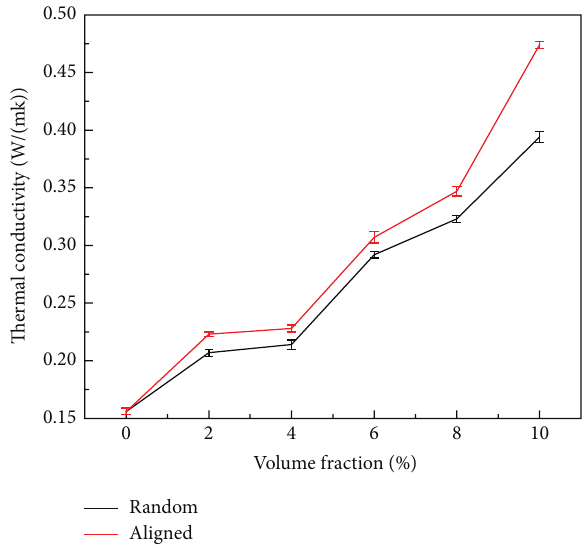
Figure 6: Thermal conductivity of